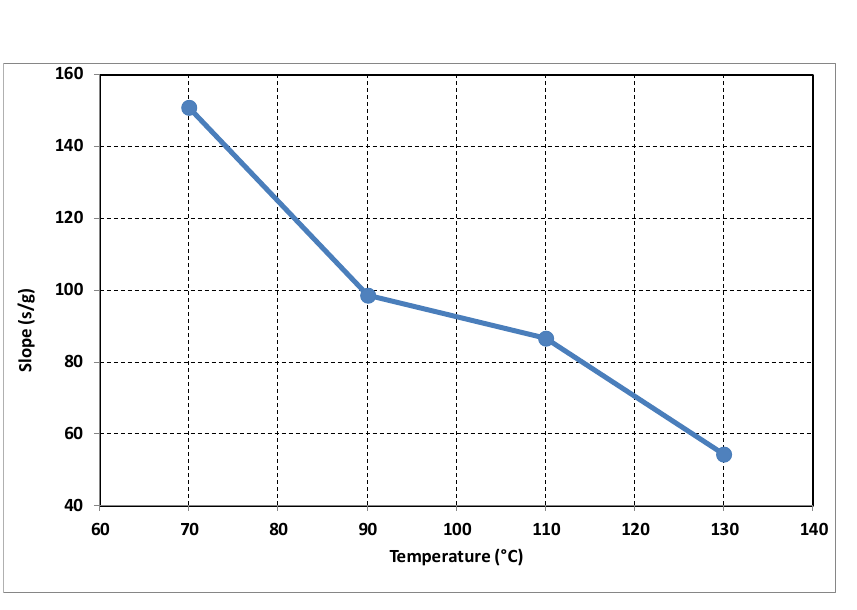
Figure 6. The slope of the linear approximation curves as a function of temperature.